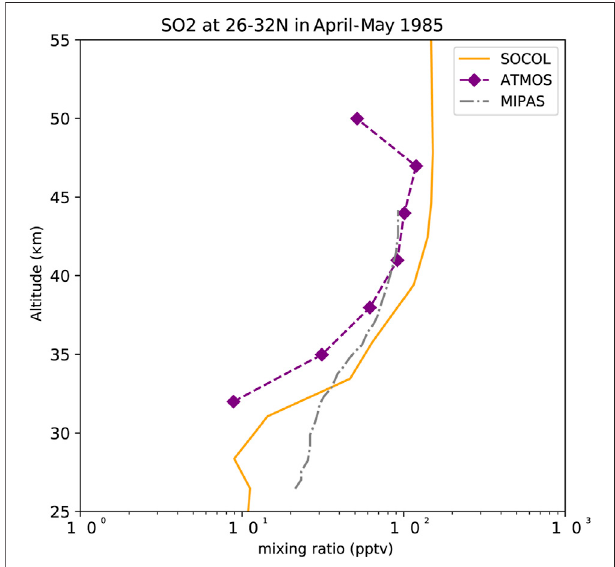
FIGURE 1 | Comparison of the SO2 mixing ratio at 26 – 32 ° N in april to May 1985 simulated by SOCOL-AER (orange solid line), from ATMOS observations (purple squares) and from MIPAS measurements (gray